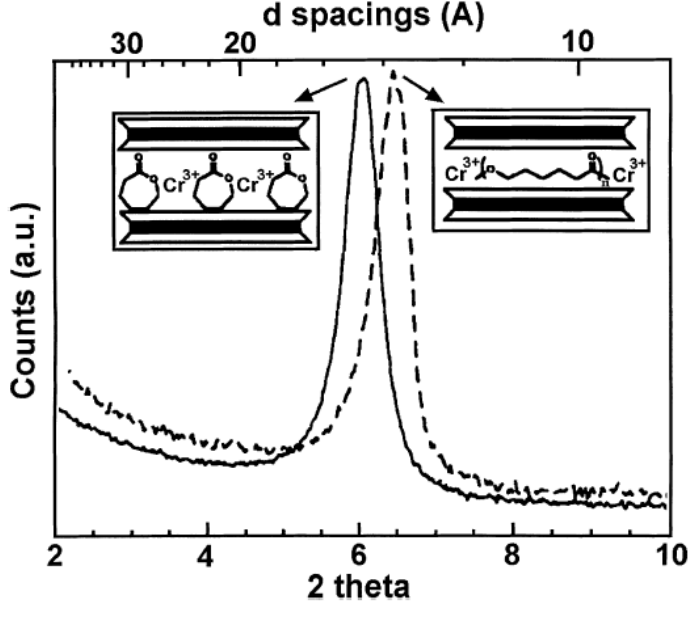
18. X-ray diffractograms of the intercalated filler (solid line) and the poly(caprolactone) based nanocomposite material (dashed line). Reproduced from reference [73] with permission from The American Chemical